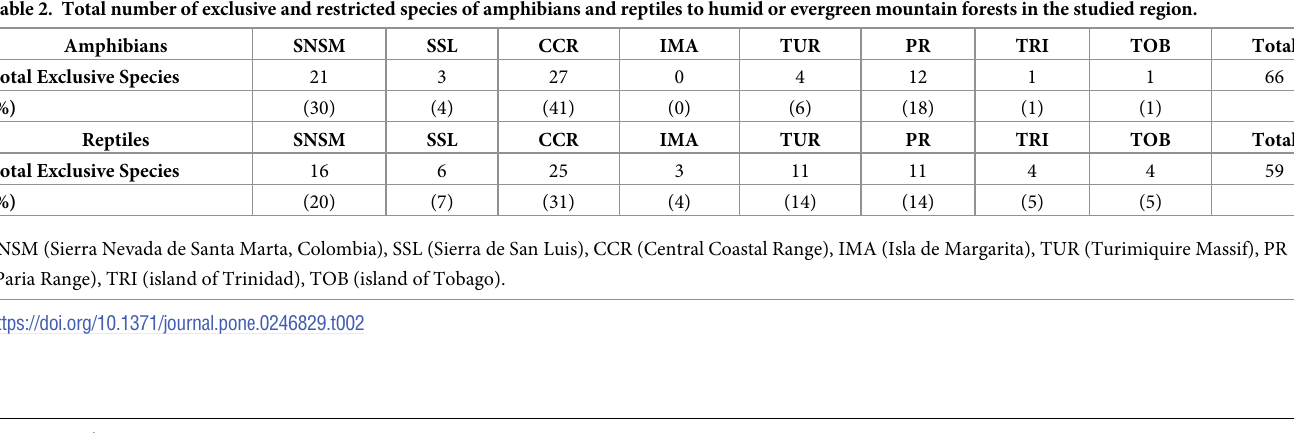
(Tables 1 and S3). In detail, the Cerro La Cerbatana has 19 species, followed by Cerro Cam- peare with 16 species, and the Paria Range with 72 species. Despite the 90 km separation cre- ated by the Unare depression between the eastern and the CCR, and a distance of 340 km separating the SNSM (Colombia) from the Venezuelan portion of this mountain system, the overall high number of shared species in two or more mountain systems (n = 118) among regions suggests a similar ancestral origin of species in the area or argues for efficient dispersal. Among the shared species, 92 (78%) are reptiles and 26 (22%) amphibians (S3 Table). This is perhaps explained by the greater relative dispersal capability of reptiles.